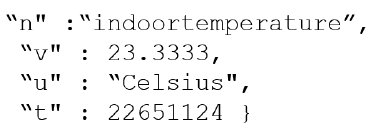
Figure 5. Example of the payload sent by the service provider.